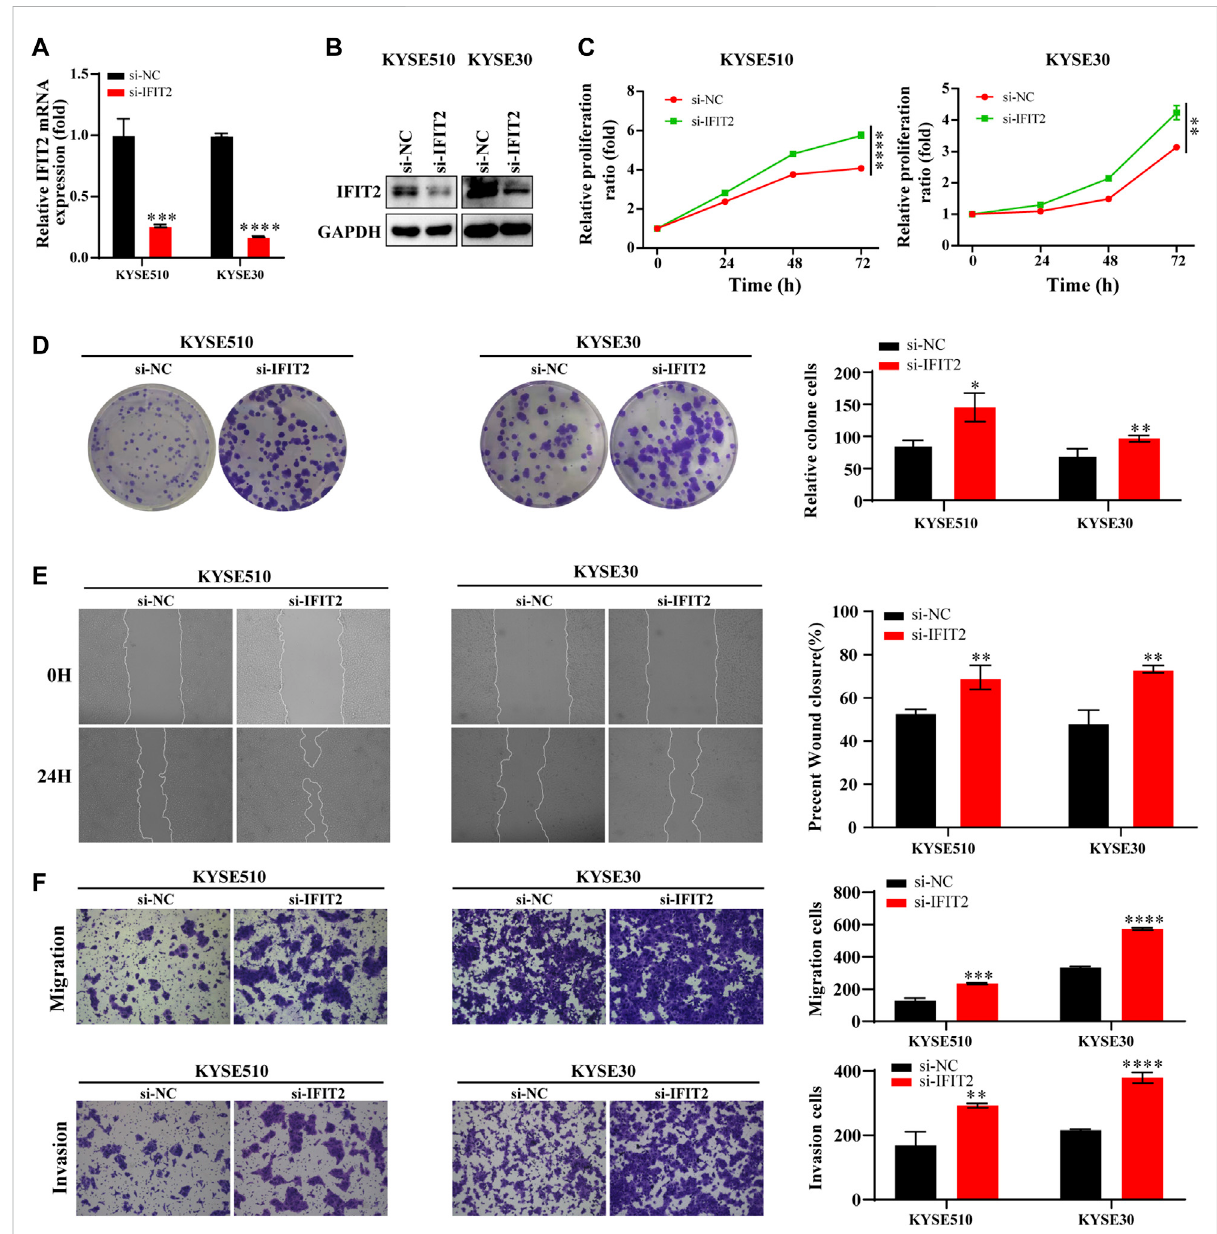
Effect of IFIT2 siRNA on ESCC cell proliferation, migration, and invasion (A, B) . To evaluate the effectiveness of si-IFIT2, qRT ‒ PCR was used to detect mRNA levels, and western blot analyses were used to detect protein levels. (C) . A CCK-8 assay was used to evaluate the proliferation ability of KYSE510andKYSE30cellsaftersi-IFIT2. (D) .Cellproliferation capabilitieswereidenti fi edthroughcolonyformationtestsintransfectedKYSE510and KYSE30 cells. (E) . The healing experience reduced the KYSE510 and KYSE30 cell ability to migrate. (F) . Transwell assays were used to